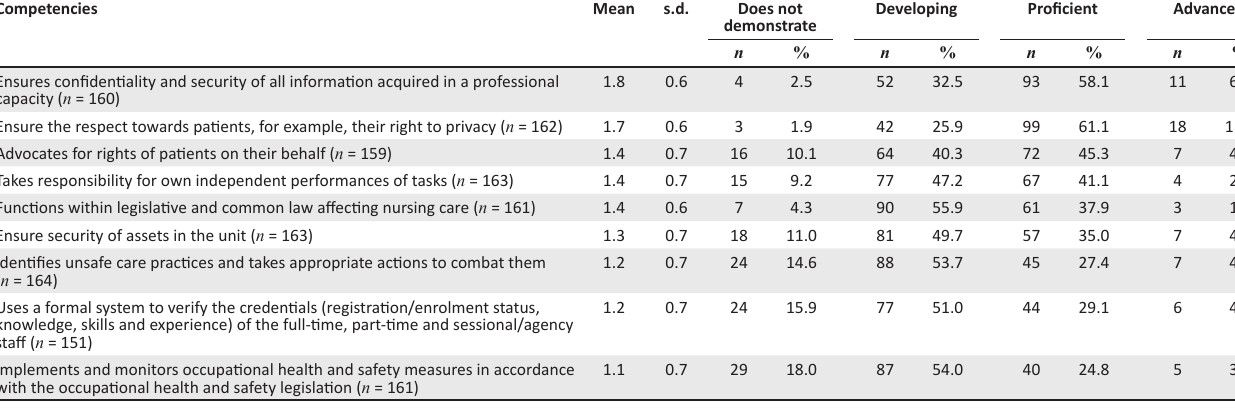
TABLE 3: Competence rating for legal framework and ethical practice.